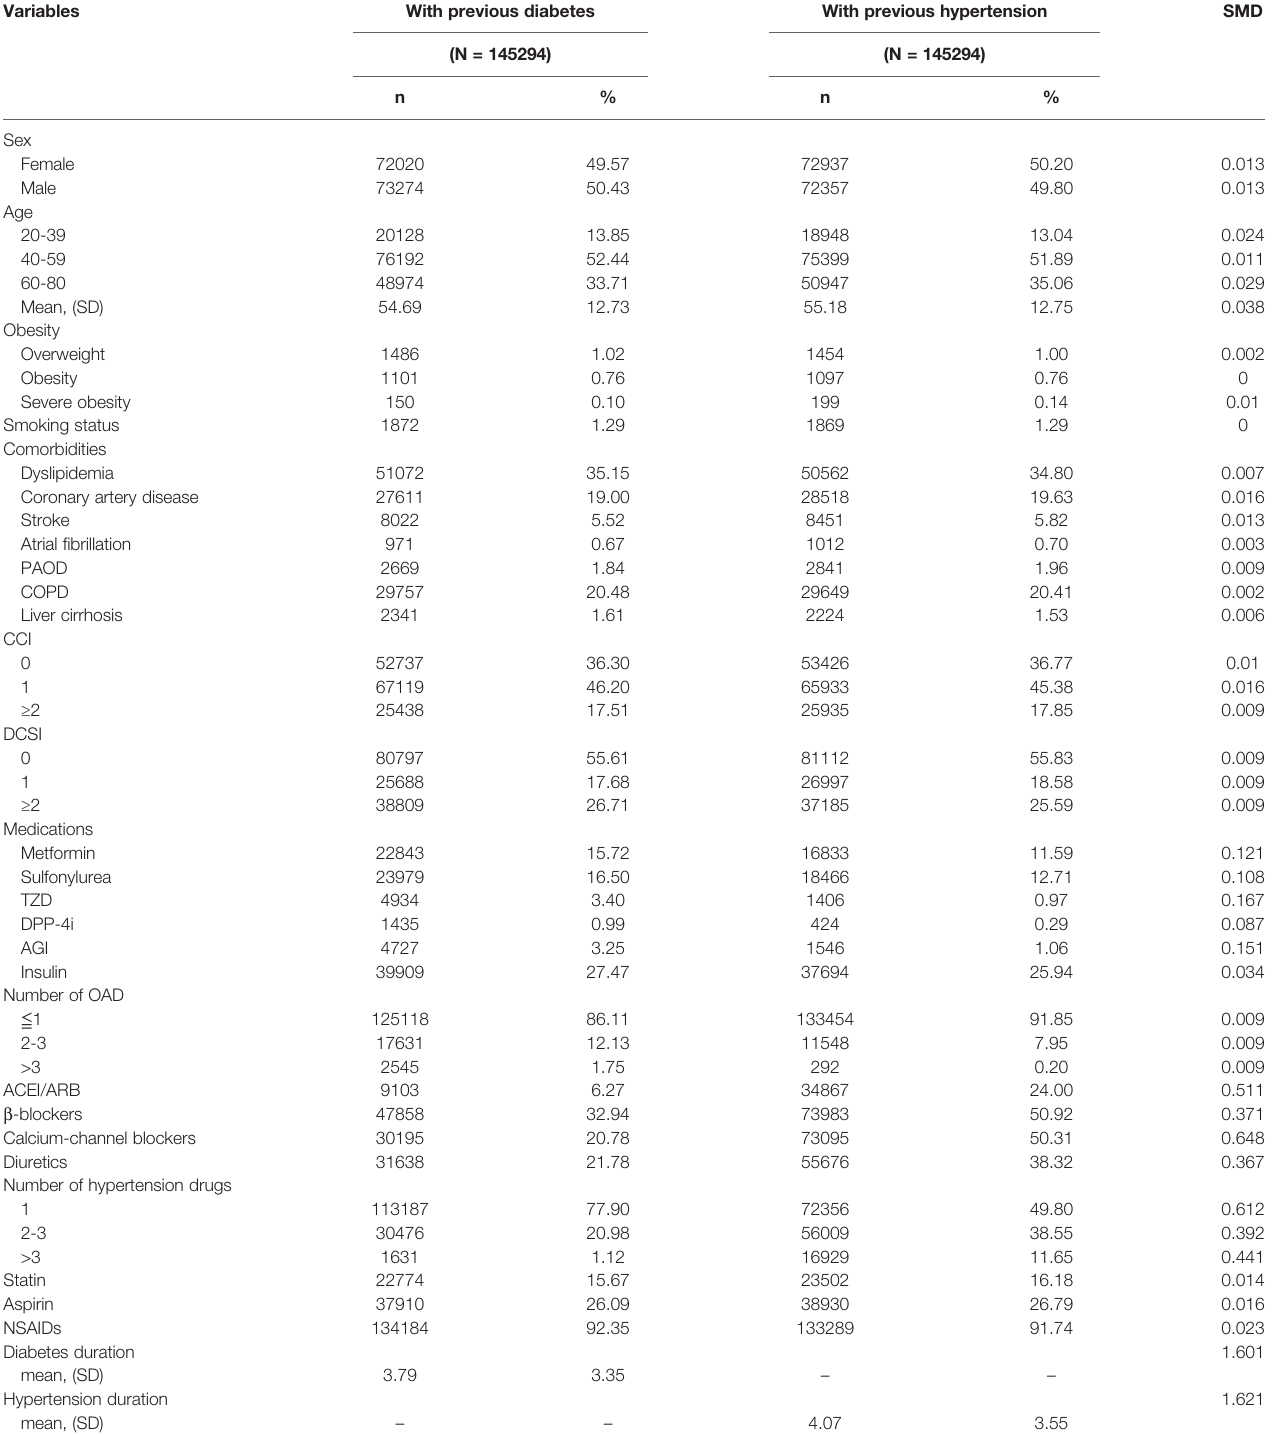
TABLE 3 | Comparison of baseline characteristics of the study subjects in the comorbid cohort.